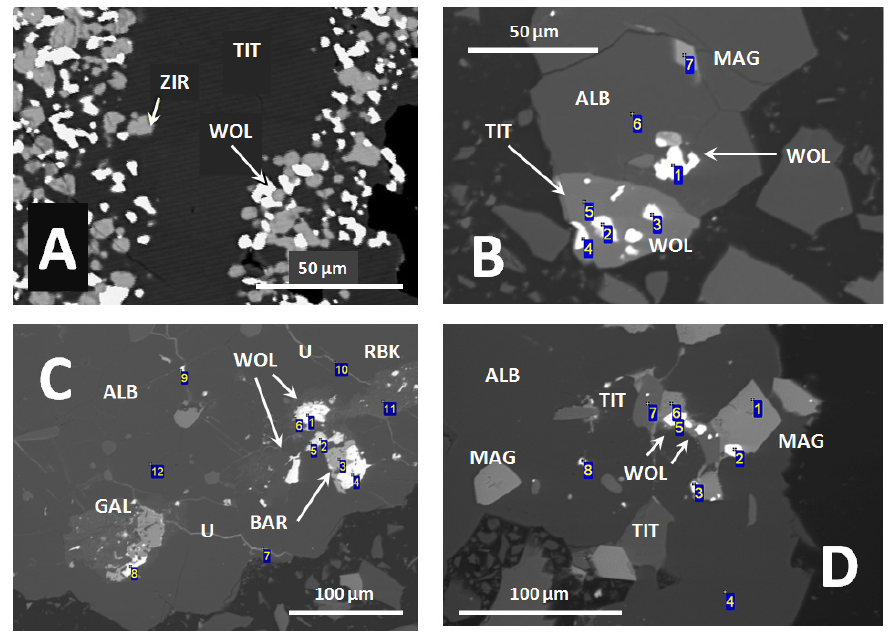
Figure 5. SEM Images of ore from Jacque’s Lake showing typical occurrence of uranium as inclusions in titanite (TIT) magnetite and albite (ALB). Andy Wilde unpublished